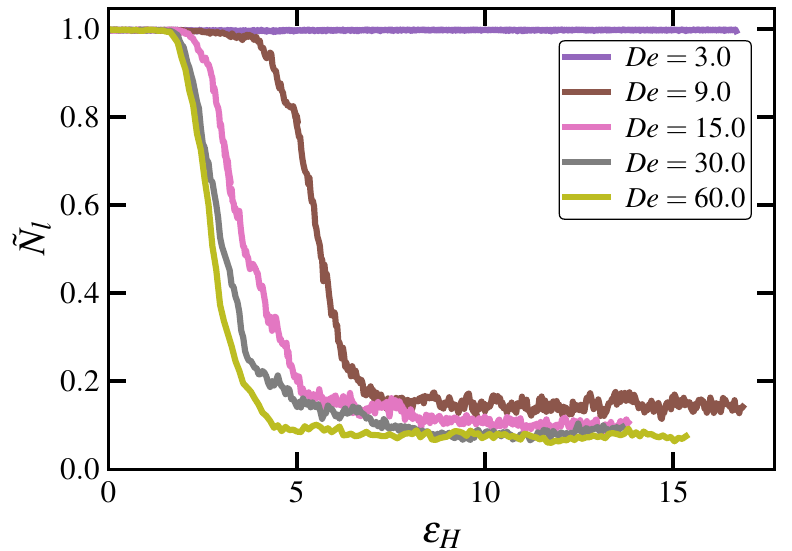
Figure 14. Fraction of liquid-like particles, ˜ N l , as a function of Hencky strain within the PE material for startup of UEF at various De